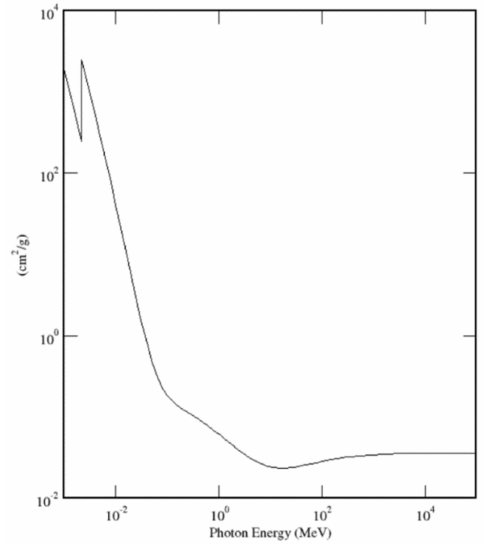
Figure 22. Phosphorus photon cross